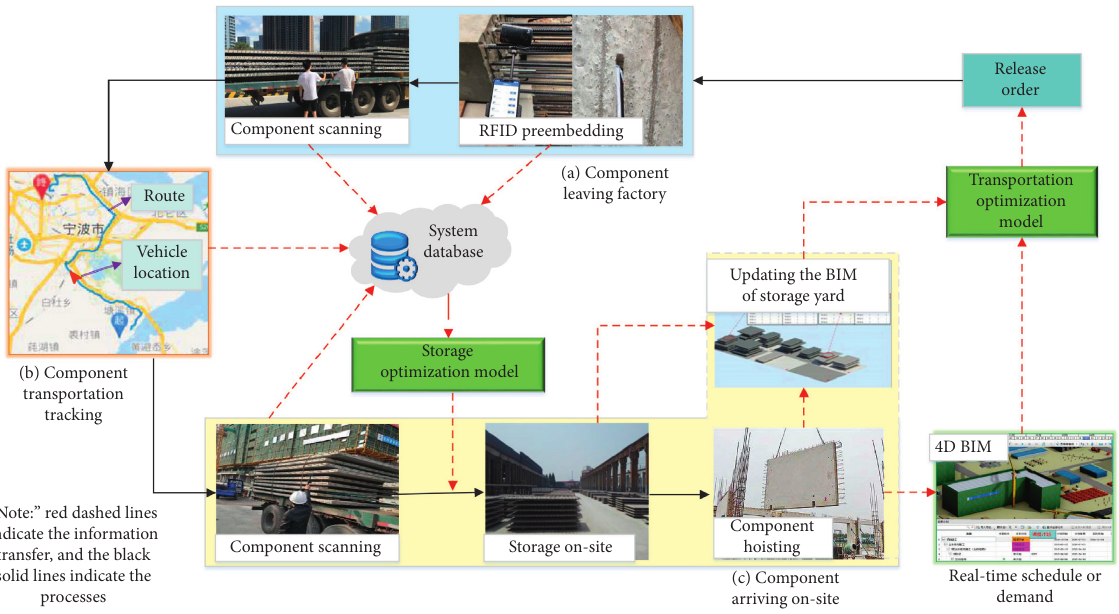
Figure 2: Schematic diagram of whole-process transportation